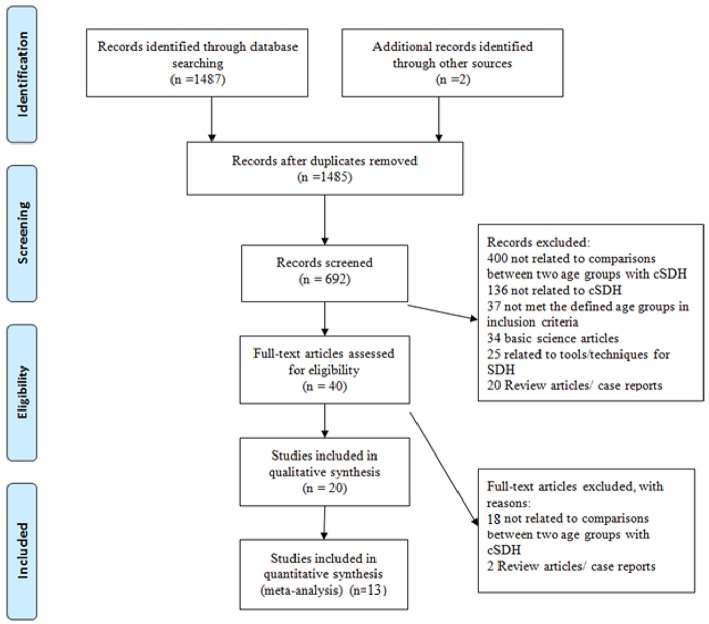
PRISMA Flow Diagram for search strategy and literature selection.